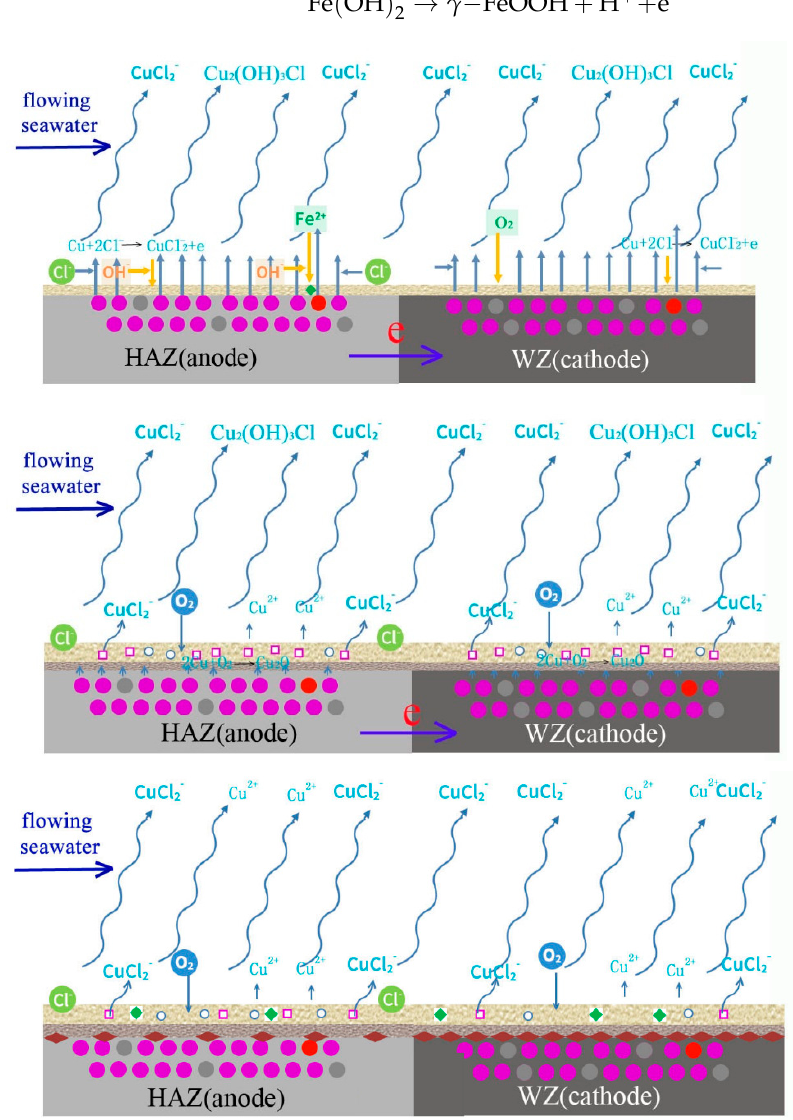
Figure 22. Schematic diagram of corrosion mechanism of cupronickel welding .